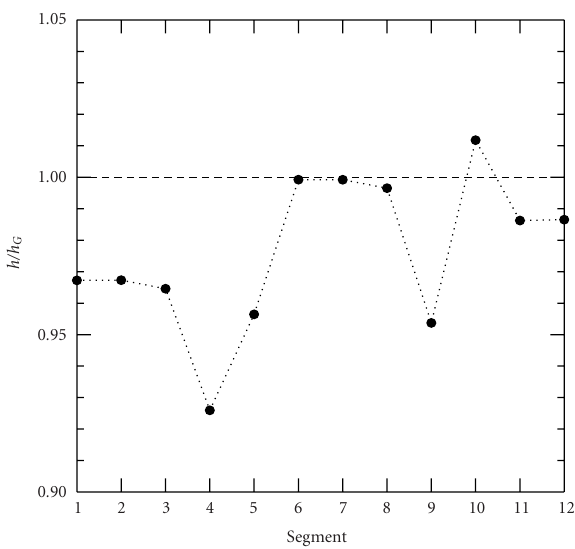
Figure 2.1. Plot of the relation h/h G calculated independently for twelve segments of length τ = 200. Most of the points are under the h/h G = 1 line, indicating a leptokurtic characteristic of each time